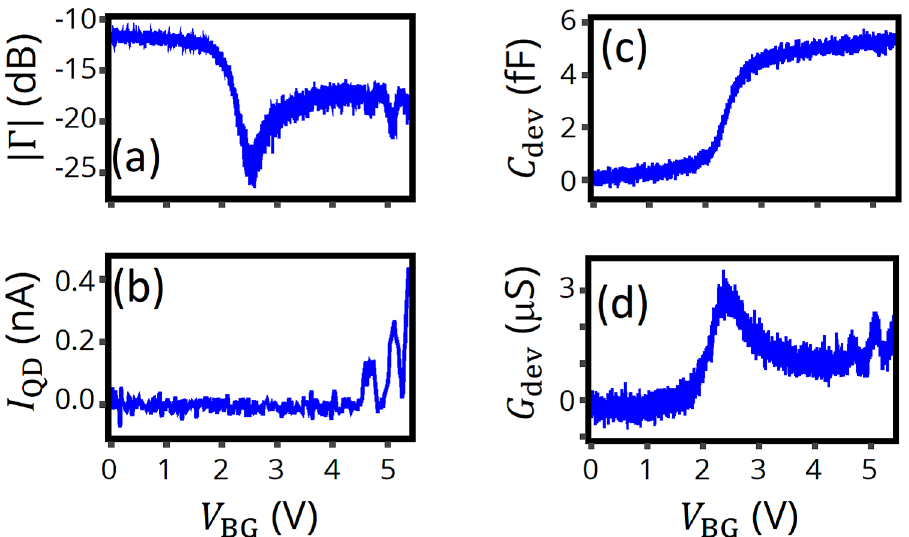
Figure 3. Back gate voltage dependence of RF reflectometry. ( a , b ) Amplitude of the reflection coefficient, | Ŵ | , and QD current, I QD , as a function of V BG at liquid helium temperature. Carrier frequency f = 223.464 MHz, V DS = 5 mV. V GL1 , V GL2 , and V GR1 are floating. As V BG is increased, a large dip appears in | Ŵ | around V BG = 2.5